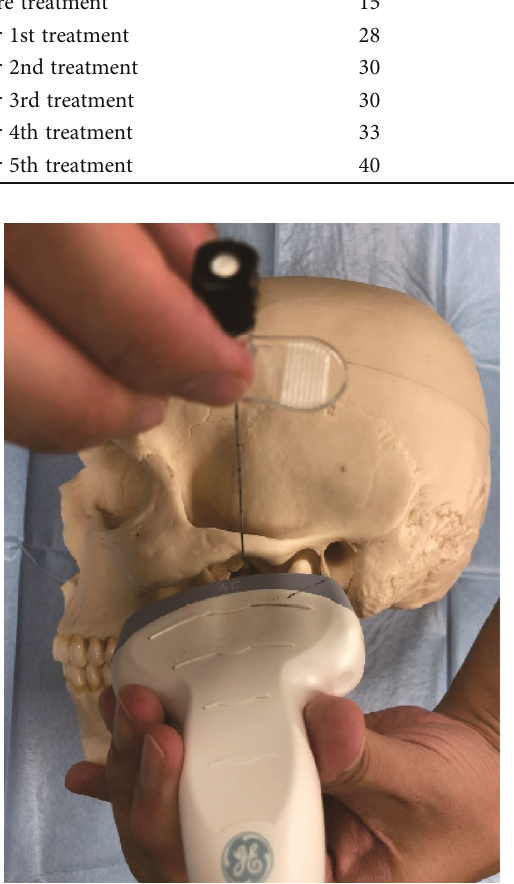
Figure 1: The technique of ultrasound-guided inferior alveolar nerve block.